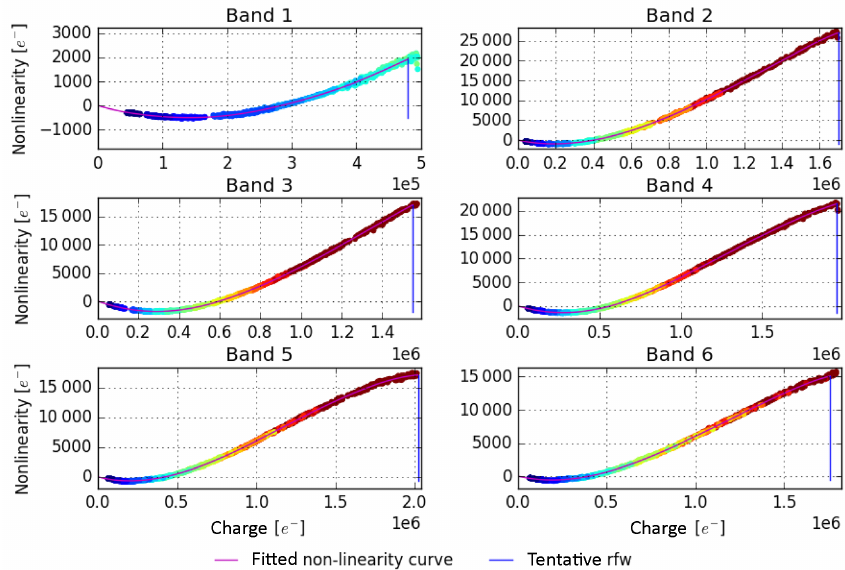
Figure 7. For each UVN band the obtained non-linearity curve (purple line) together with the scatter plot of the individual non-linearity tuples (coloured dots) are shown. The horizontal axis represents the measured charge and the vertical axis the obtained non-linearity. Each colour indicates a sub-cloud from the pixels of an individual measurement with a certain exposure time. The blue vertical line indicates the limit chosen for the validity of the correction; this is the value for register full well.